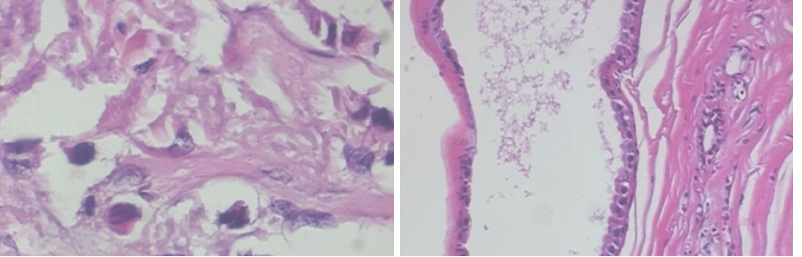
Figure 15. Sample misclassified images. Left is a misclassified malignant image, and right is a misclassified benign